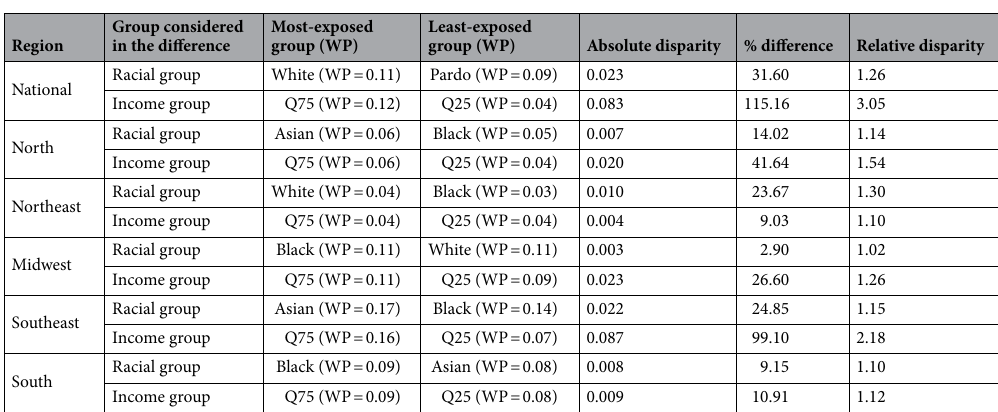
Table 1. Difference between the population-weighted weather penalty for the most-exposed group (racial and income group) versus the least-exposed group (Main analysis). Note 1 : population-weighted weather penalty (WP), third quartile of the income distribution (Q75), first quartile of the income distribution